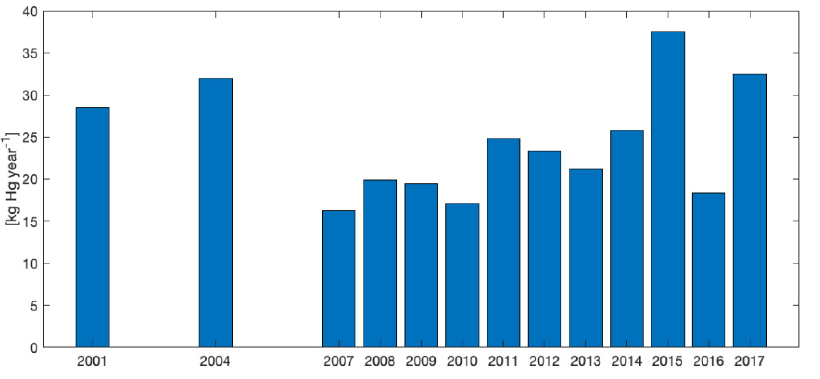
Figure 7. Total annual release of Hg to air as reported in the E-PRTR database by the industrial facility located in Pieve Vergonte.